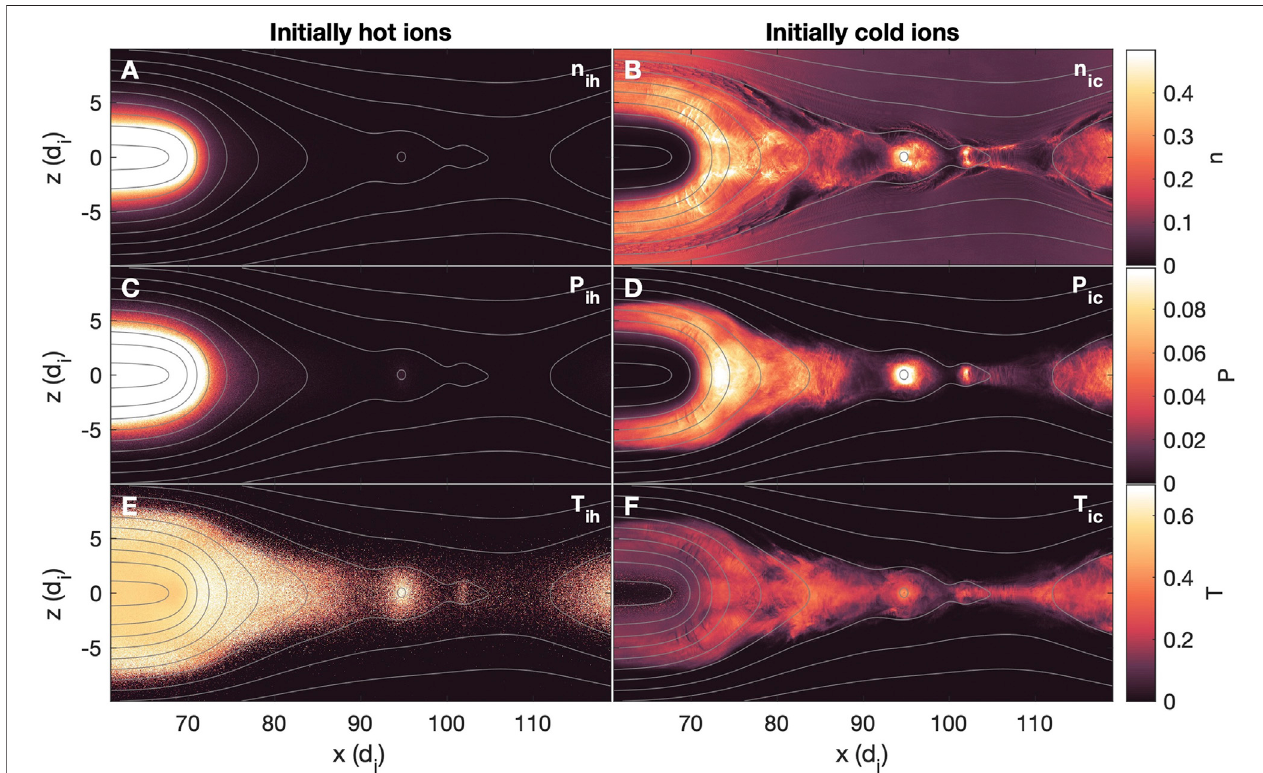
FIGURE 2 | Density, pressure, and temperature of initially hot and cold ions at t ω ci (cid:1) 120: (A) n ih , (B) n ic , (C) P ih , (D) P ic (E) T ih , (F) T ic . The initially cold plasma dominatethedensityandpressureat x ≳ 71and x ≳ 71,respectively.Whilethehottemperatureexceedsthecoldtemperatureinlargepartsoftheexhaust,theireffecton the dynamics inside the exhaust isnegligible due to their low density. The initially cold ions are heated totemperatures comparable to the initial temperature ofthe Harris sheet ions.